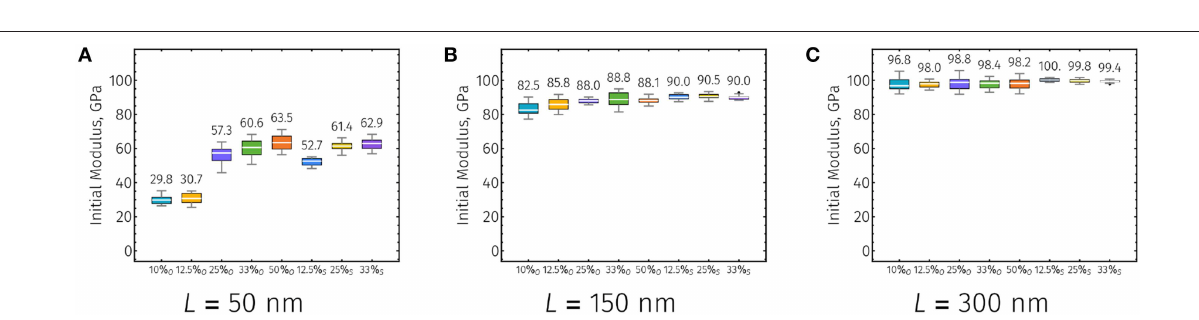
FIGURE 5 | Initial modulus box-whisker plots (20 independent simulations for each structure) of CNC films with approximate base fiber lengths (A) L = 50nm, (B) L = 150nm, and (C) L = 300nm. Colors in each plot correspond to various fiber ordering schemes. White horizontal lines, colored box, gray vertical lines, and black dots indicate the median, interquantile range (IQR) between 3rd and 1st quantiles, range (of all data within ± 1.5 × IQR), and outliers (points outside the range), respectively. Numeric values of the distribution medians are listed above their respective box